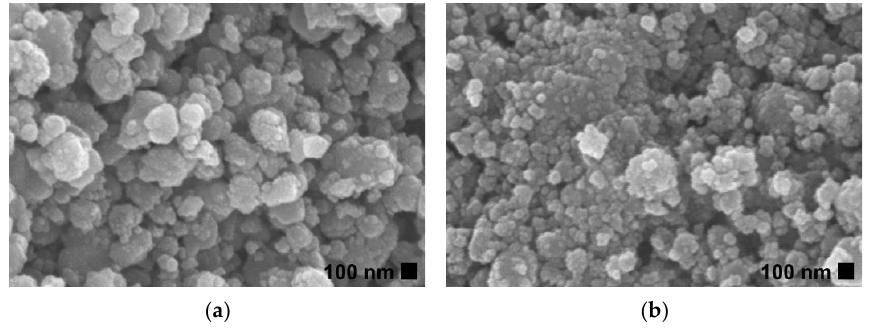
Figure 2. SEM images of ( a ) ZnO and ( b ) Ti-ZnO NPs.